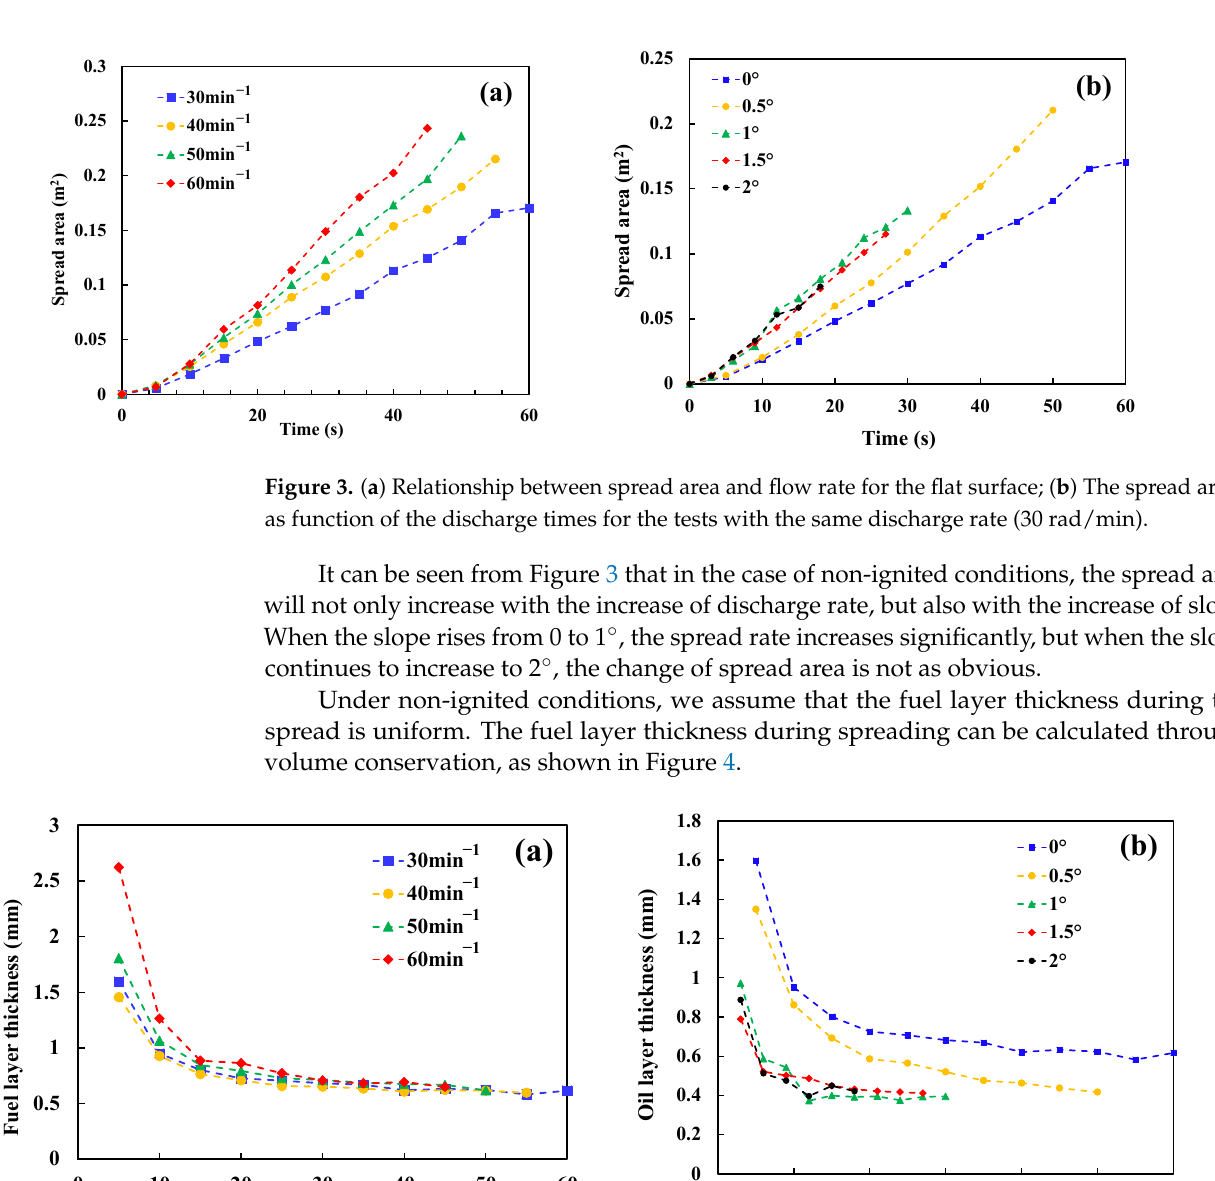
Figure 2. Approximate shape of spread area under non-ignited conditions. ( a ) On the flat surface; ( b ) On the inclined surface. Under the non-ignited condition, the spread areas of fuel with different discharge rates and slopes are shown in Figure 3.